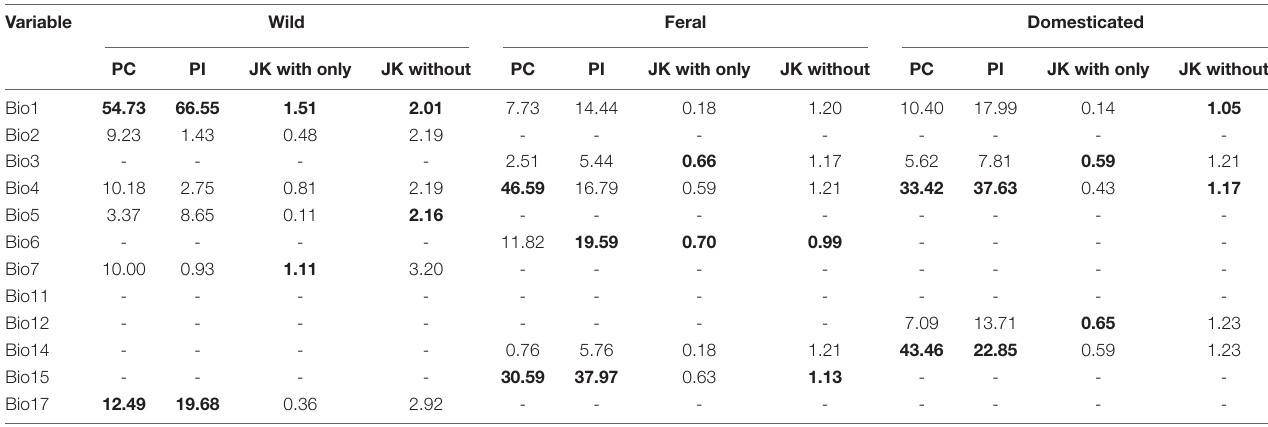
TABLE 1 | Importance of variables to model construction.